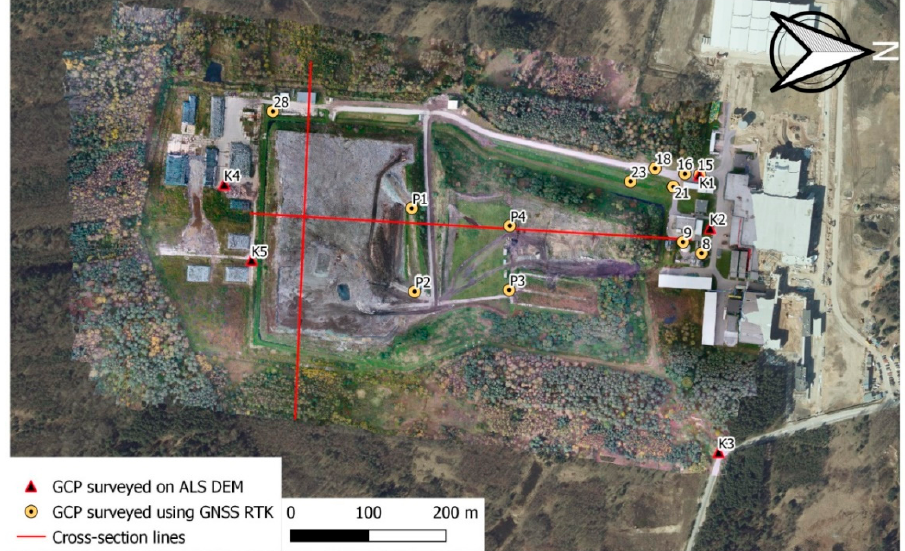
Figure 2. Landfill in Promnik—orthophotomap of UAV made images (2020) overlaid on orthopho- tomap of arerial images from 2015.